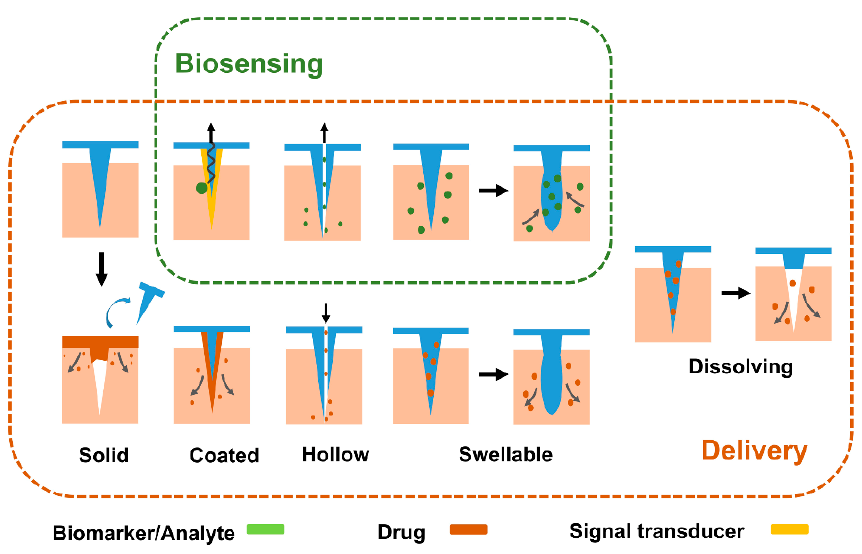
Figure 3. Schematic illustration of MN categories and their common application fields (authors’ own work).